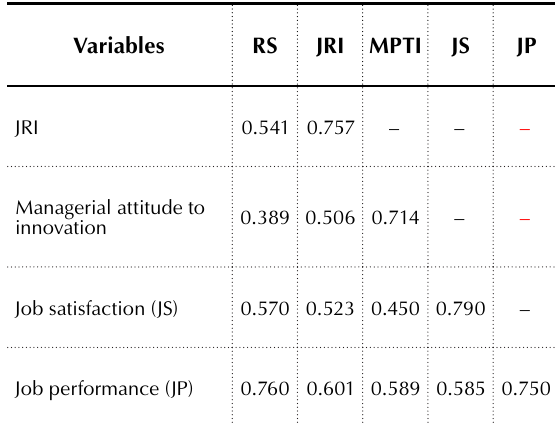
Table 3. Composite reliability, Cronbach’s alpha, AVE and R 2